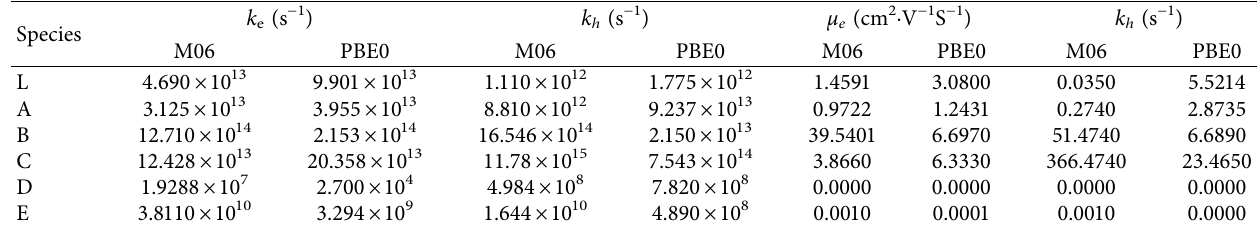
Table 7: Computed values of charge transfer rates ( k e / h ) and charge transfer mobilities ( μ e / h ) at the M06/D3/def2-TZVP and PBE0/D3/def2- TZVP levels of theories in the gas phase.